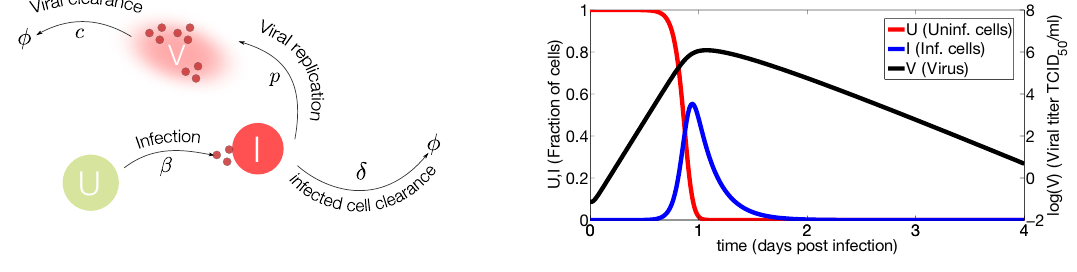
Figure 2. Target cell model. ( Left ) IAV ( V ) infects susceptible cells ( U ) with rate β . Infected cells are cleared with rate δ . Once cells are productively infected ( I ), they release virus at rate p and virus particles are cleared at rate c . The symbol φ represents clearance; ( Right ) Computational simulations of the target cell model. Parameter values used for model simulation are taken from [26]. The susceptible cells (red line) are rapidly infected while the virus (black line) and infected cells (blue line) peak at day one approximately. The viral growth is limited by the number of susceptible cells, decreasing the viral load and the number of infected cells to undetectable